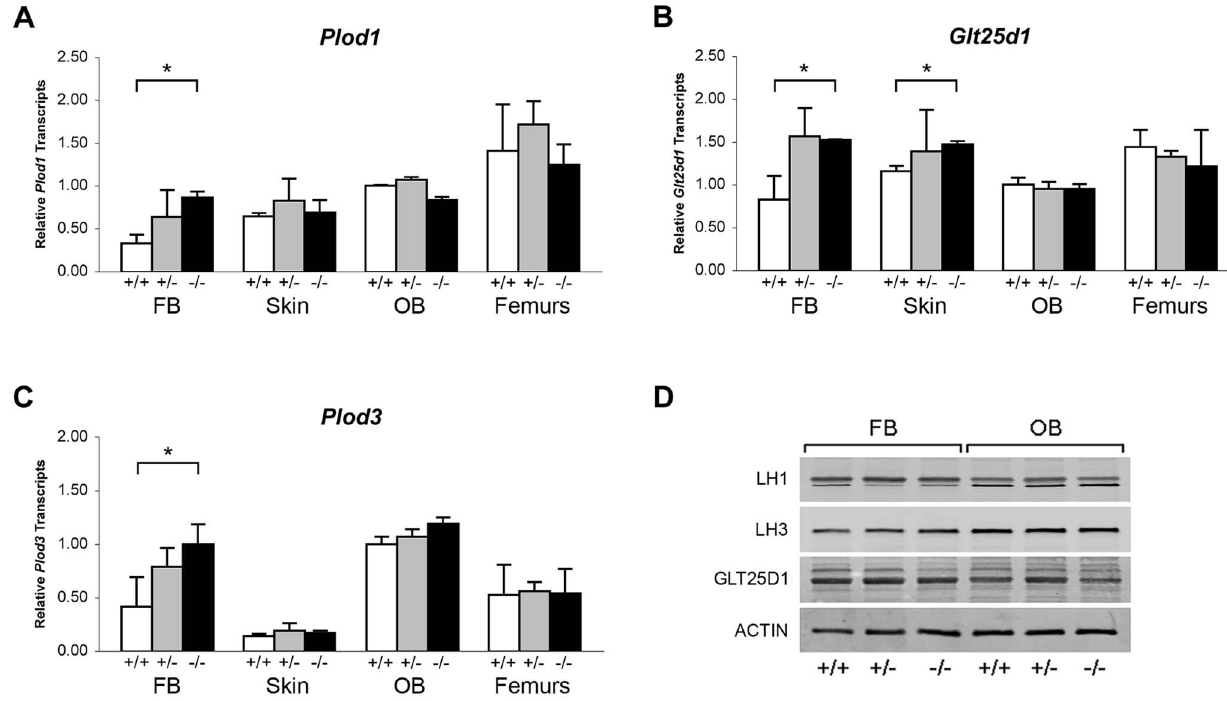
Figure 8. Expression of ER resident collagen helical lysine modification enzymes. (A–C) Real-time RT-PCR of total RNA from two independent cell cultures of newborn fibroblasts (FB) and calvarial osteoblasts (OB), and 5 independent skin and femoral samples for each genotype at 8 weeks of age. (D) Western blots of cell lysates probing for lysyl hydroxylase 1 (LH1/PLOD1), lysyl hydroxylase 3 (LH3/PLOD3), glycosyltransferase 25 domain containing 1 (GLT25D1), and b -actin in wild-type ( + / + ), heterozygous ( + / 2 ) and homozygous ( 2 / 2 ) Ppib -null cells and tissues.